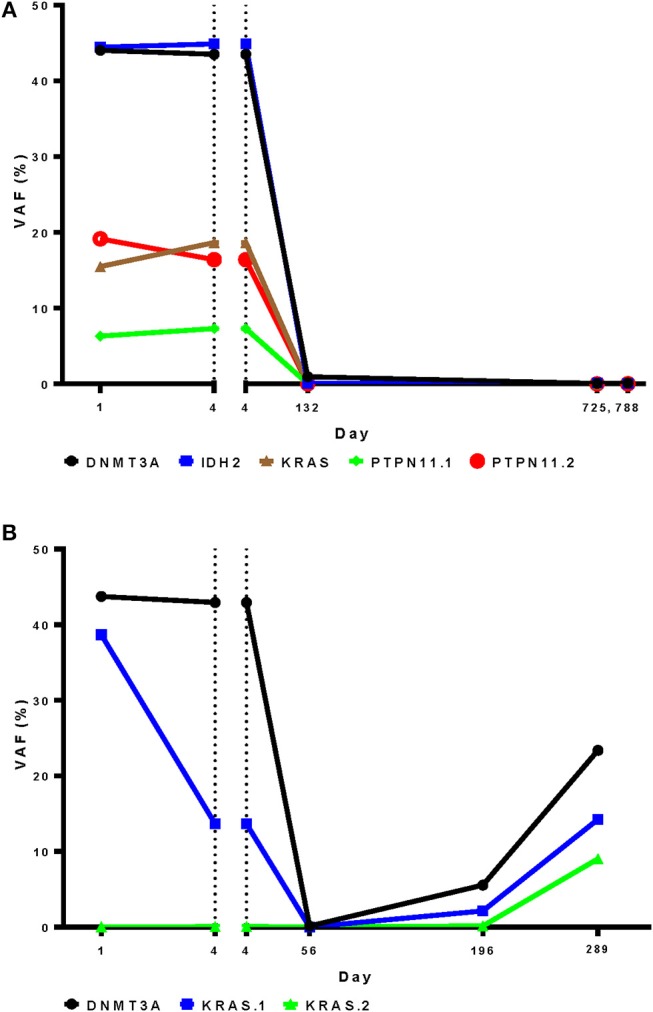
Targeted DNA sequencing for residual disease may be more informative after, rather than during, initial chemotherapy. A DNA sequencing panel customized to patient-specific variants was used to for analysis of longitudinal blood samples from during and after induction therapy in two patients who achieved complete remission. (A) Variant frequency was unchanged in the first patient between day 1 and 4 during therapy, despite achievement of a durable complete remission (B). In the second patient a DNMT3A variant changed little during therapy, in contrast to a KRAS variant that was markedly reduced. Relapse occurred on day 154. Both mutations were detected In blood from day 196 followed by the emergence of an second KRAS mutation on day 289. VAF, variant allele frequency.